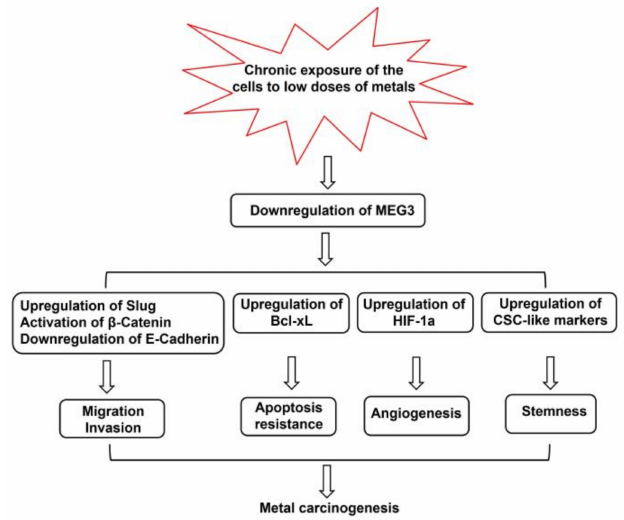
Figure 1. Representative mechanisms of MEG3 in metal carcinogenesis. Chronic exposure of the cells to low doses of metal reduces MEG3 gene expression. The downregulation of MEG3 causes (1) the activation of β -Catenin and upregulation of EMT, resulting in increased migration and invasion; (2) the upregulation of Bcl-xL; (3) an increase in HIF-1 α ; and (4) the upregulation of cancer stem cell-like markers, contributing to carcinogenesis induced by